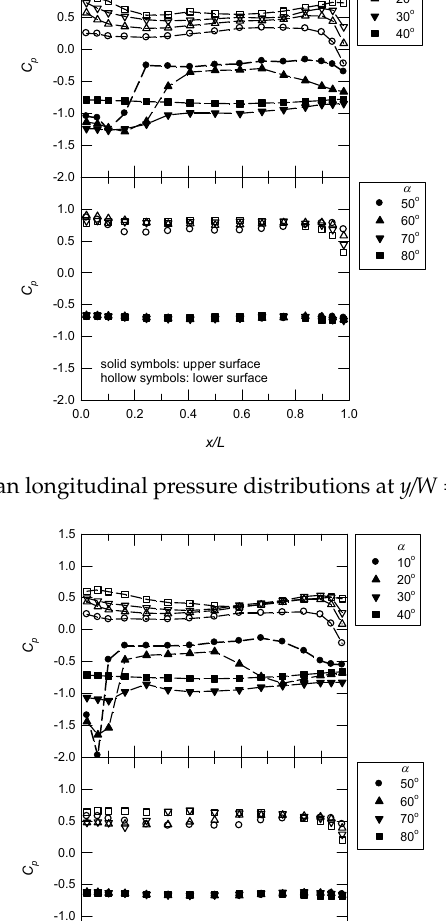
solid symbols: upper surface hollow symbols: lower surface